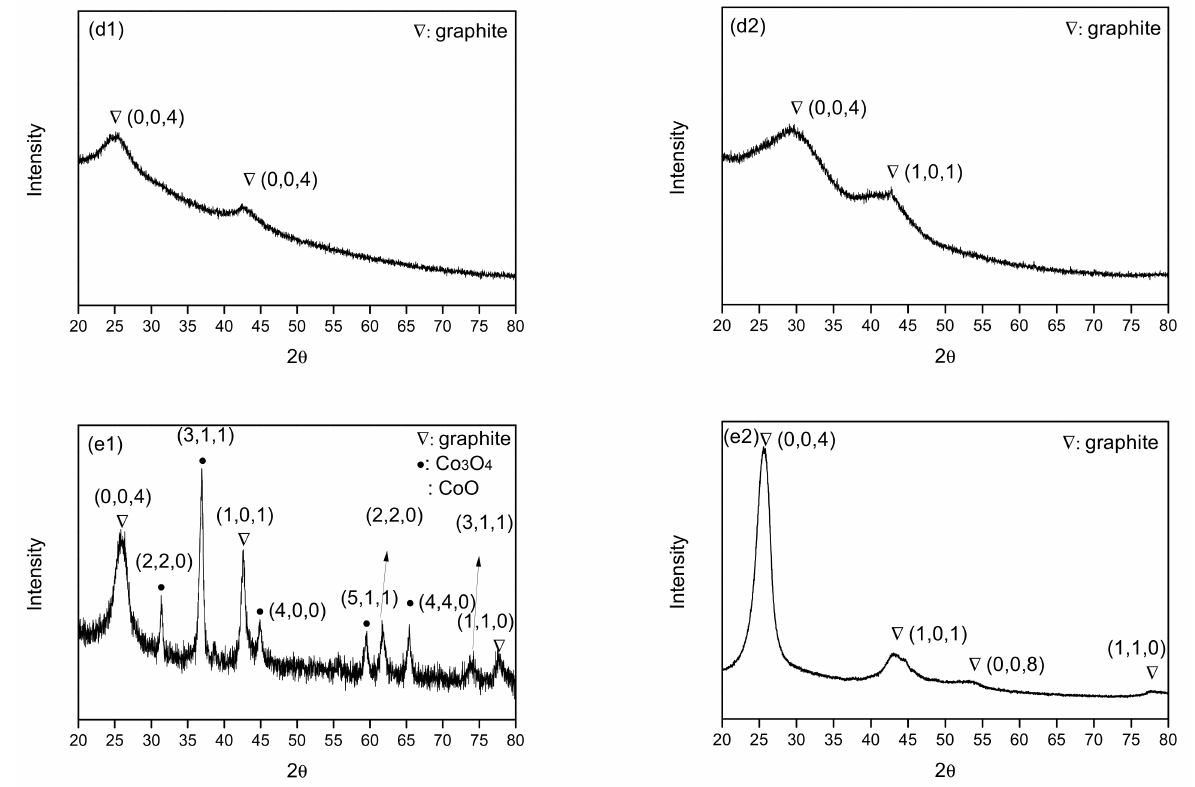
Figure 5. XRD results of sample. ( a1 ): Co/CNT, ( b1 ): Co/AC, ( c1 ): Co/GO, ( d1 ): Co/rGO, ( e1 ): Co/CNF, ( a2 ): CNT, ( b2 ): AC, ( c2 ): GO, ( d2 ): rGO, ( e2 ):